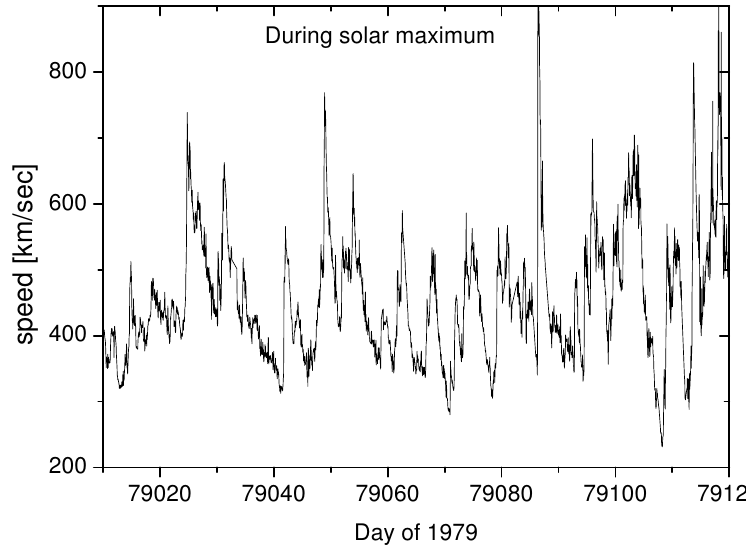
Figure 17: High velocity streams and slow wind as seen in the ecliptic during solar maximum. Data refer to Helios 2 observations in